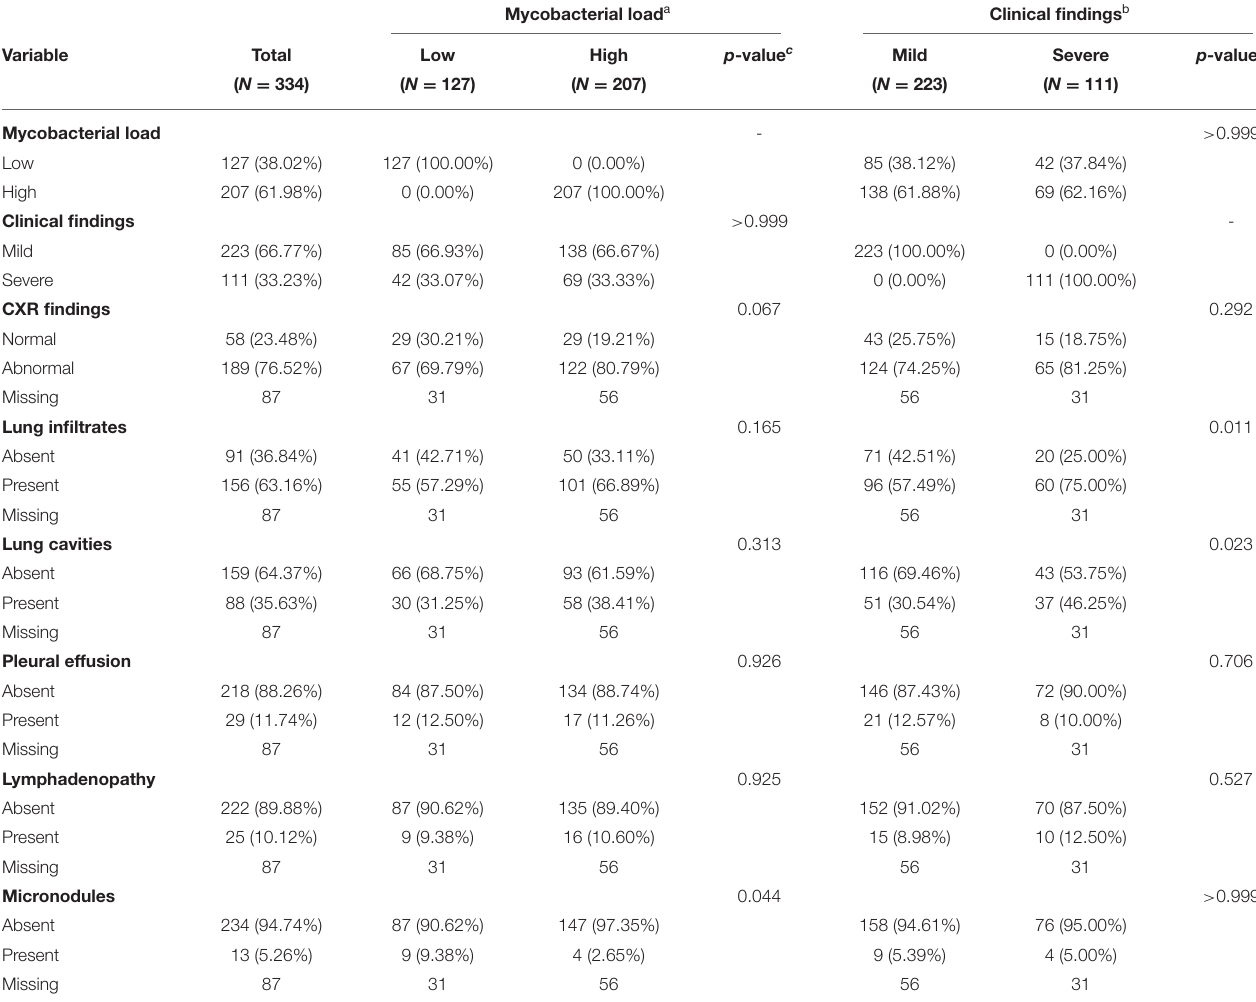
TABLE 2 | Associations among TB-disease manifestations. Mycobacterial load a Clinical findings